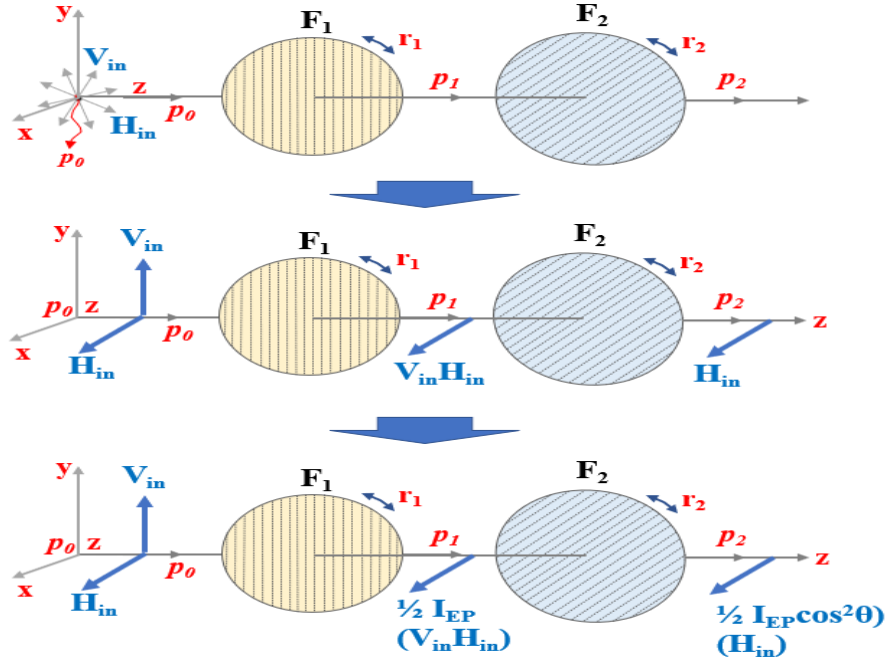
Figure 10. Specular reflection removal attained by controlling the rotation angle of the polarizing